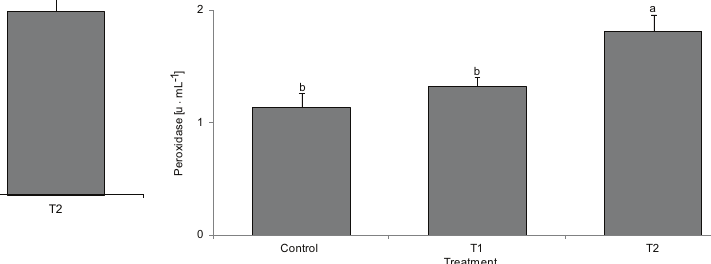
Fig. 3. Plasma peroxidase activity of tinfoil barb, Barbonymus schwanenfeldii , fed different levels of dietary probiotics (control, 0 CFU · g –1 diet; T1, 1 × 10 4 CFU · g –1 diet; T2, 1 × 10 6 CFU · g –1 diet) for 15 days. Data are presented as mean ± SE ( n = 9): Bars with dif- ferent letters were significantly different ( P < 0.05)